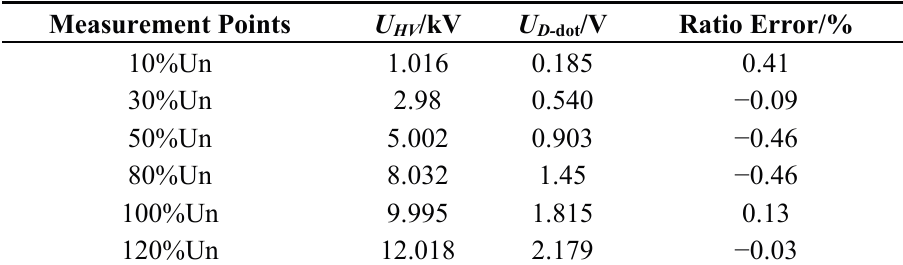
Table 1. Accuracy test results of D-dot sensor.